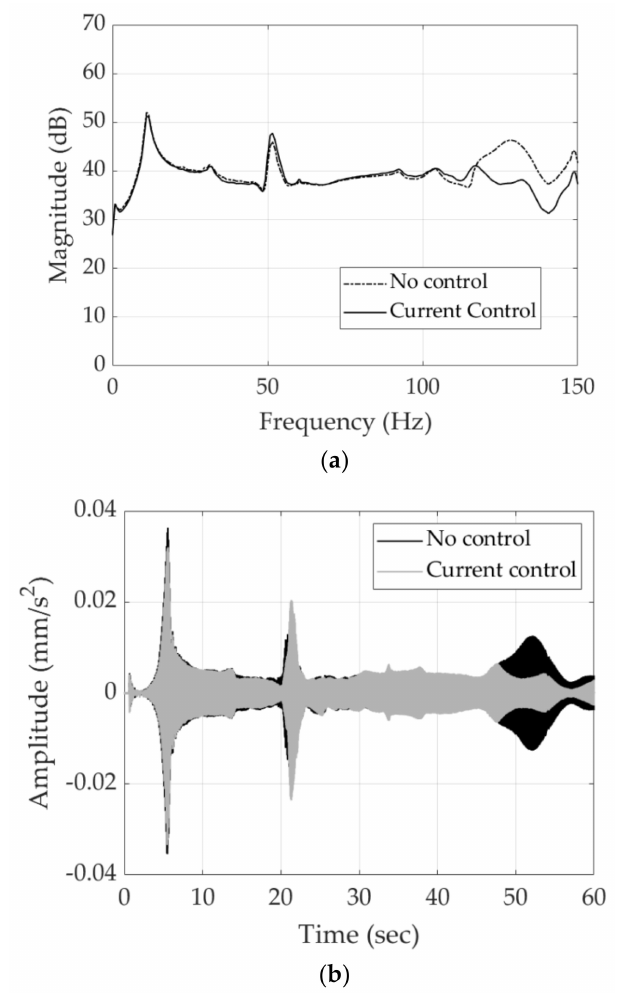
Figure 23. Vibration reduction results of adaptive tuned MRE vibration absorber by frequency-variable excitation. ( a ) Frequency response function, ( b ) Time